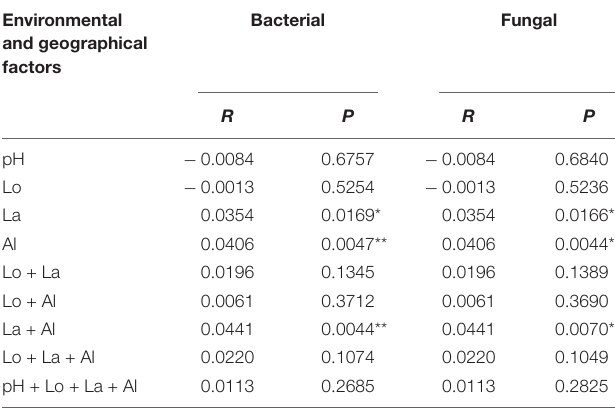
TABLE 1 | Mantel-test analysis of environmental and geographical factors with bacterial and fungal community composition. Environmental and